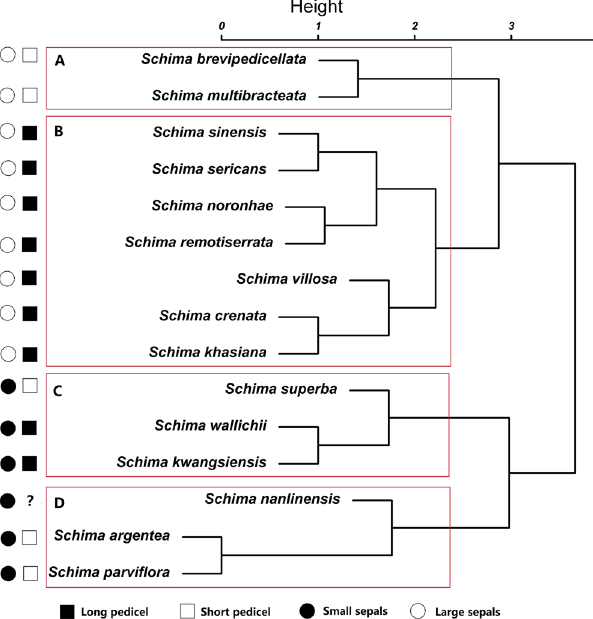
Figure 6. A cluster dendrogram of fossil and extant species of Schima in China based on fruit characters, generated and drawn by X. G. Shi using R (http://www.r-project.org/) and Adobe Photoshop